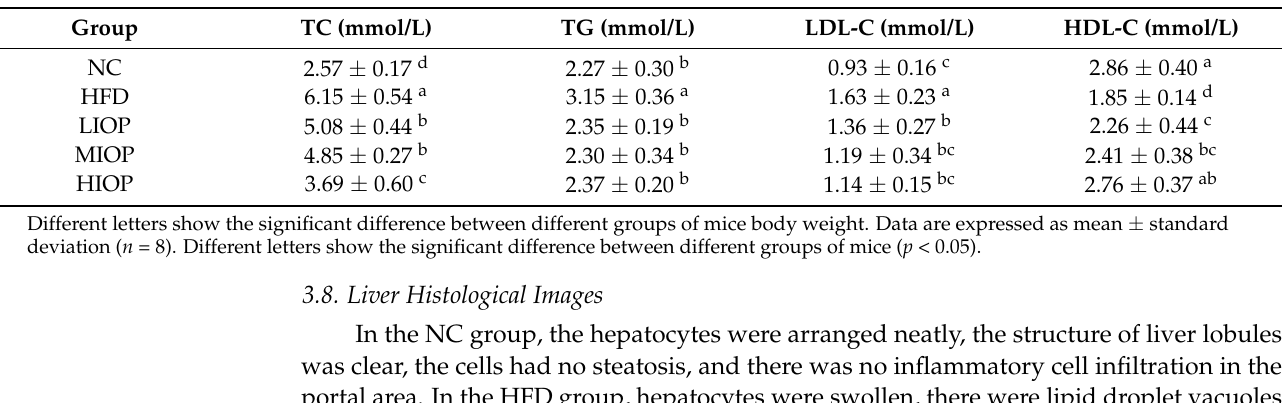
Table 3. Effect of IOP on the levels of serum lipids of experimental mice.